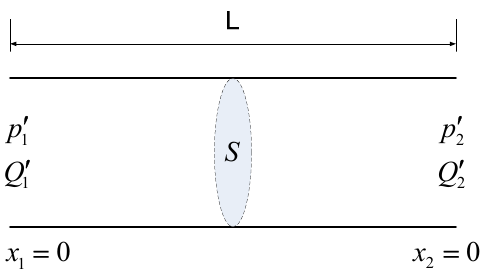
Fig. 4 Schematic of a uniform duct element of length L and area